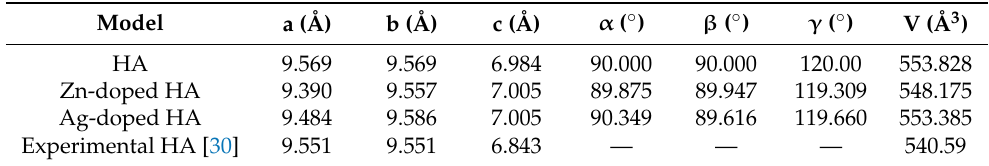
Table 1. Lattice parameters of different HA models.